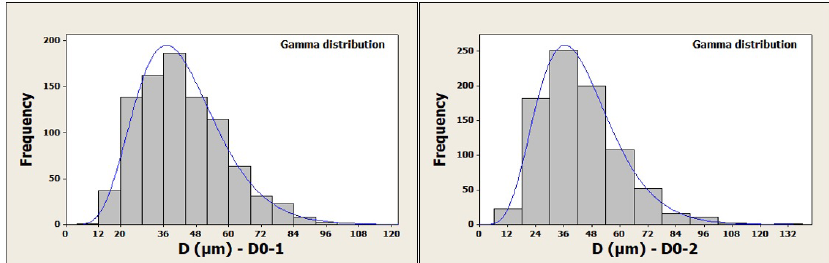
for two samples of the pure ZA27 alloy at 460ºC during 15 0